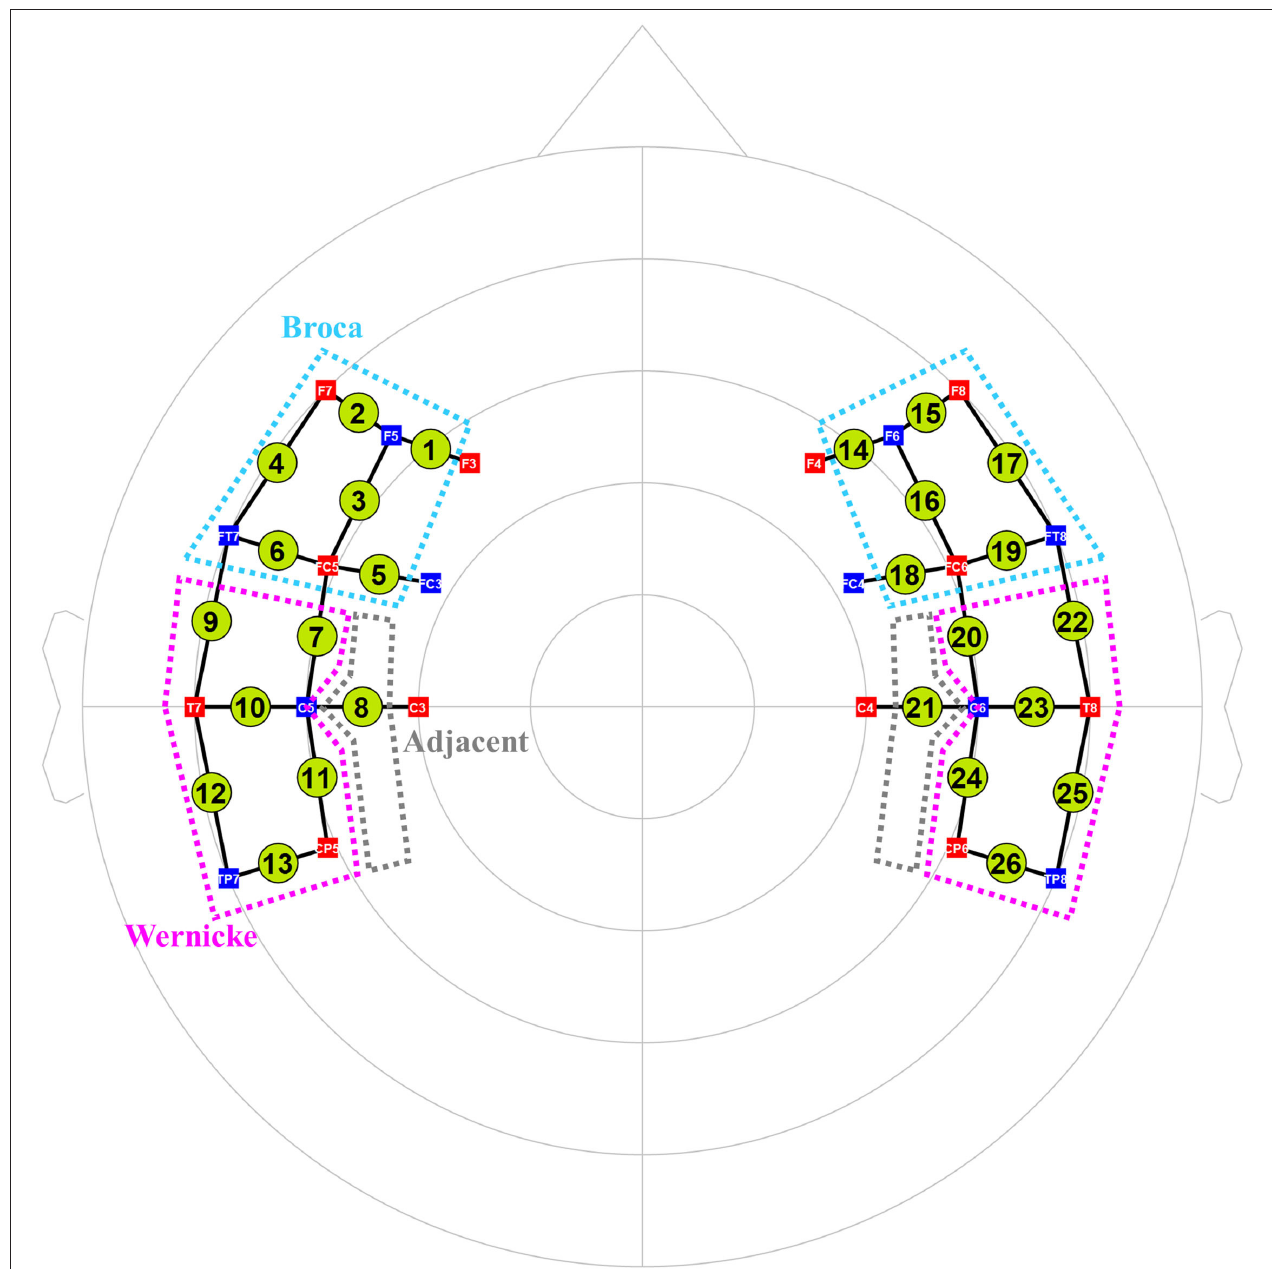
FIGURE 2 | The arrangement of 26 fNIRS channels (12 sources and 10 detectors). Total 26 channels were formed by positioning 12 sources and 10 detectors with a source-detector separation of 3cm covering Broca (cyan dotted lines) and Wernicke (pink ones) and adjacent (gray ones) areas based on the International 10–20 electroencephalography system. Green circles indicate the 26 channels with the numbers being the channel IDs. Red squares indicate the sources; blue squares indicate the detectors. The white characters in the squares mean the positions of the sources and detectors on the 10–20